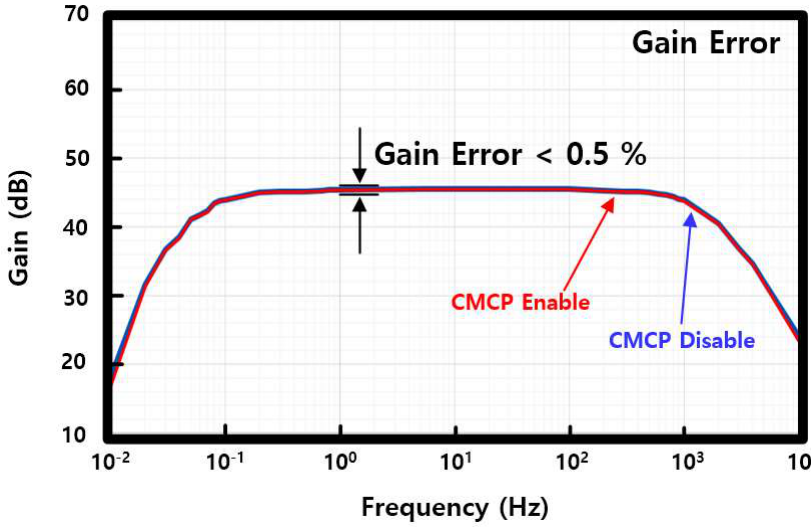
Figure 14. Gain error measurement results when the CMCP is enabled and disabled.